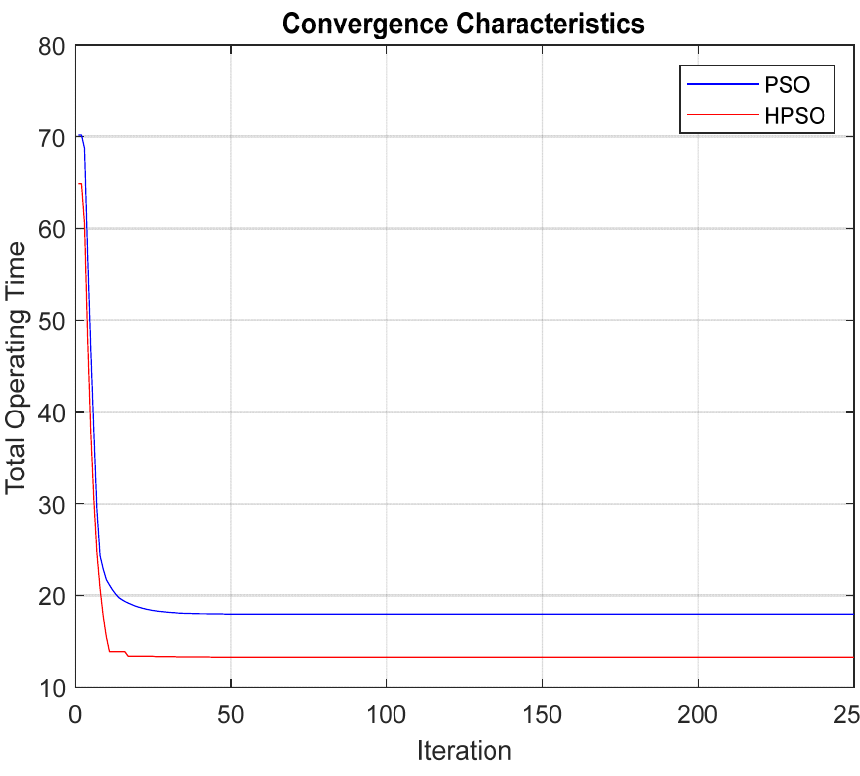
Figure 7. PSO and HPSO convergence characteristics of IEEE 14-Bus system.